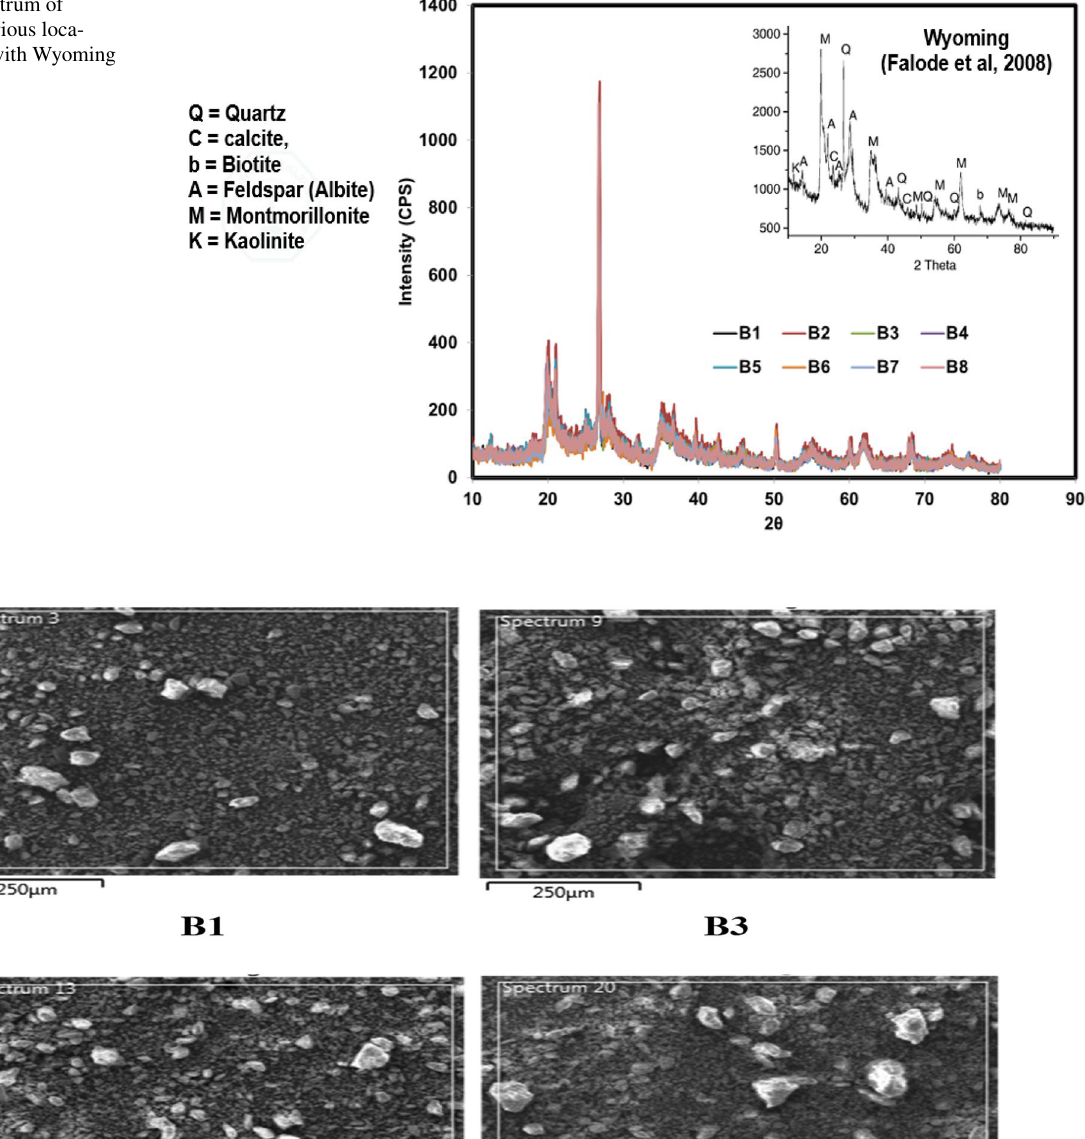
Fig. 2 XRD spectrum of samples from various loca- tions compared with Wyoming